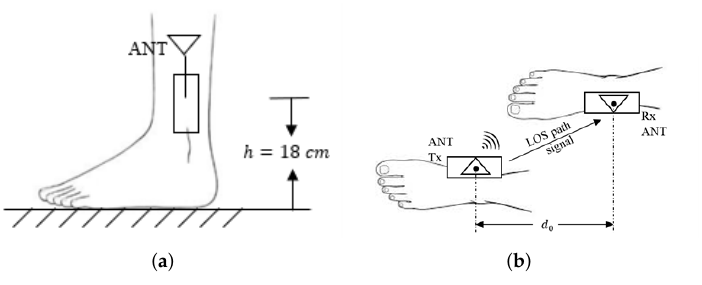
Figure 2. Schematic diagrams of the on-ankle transceivers. ( a ) Side view; ( b ) top